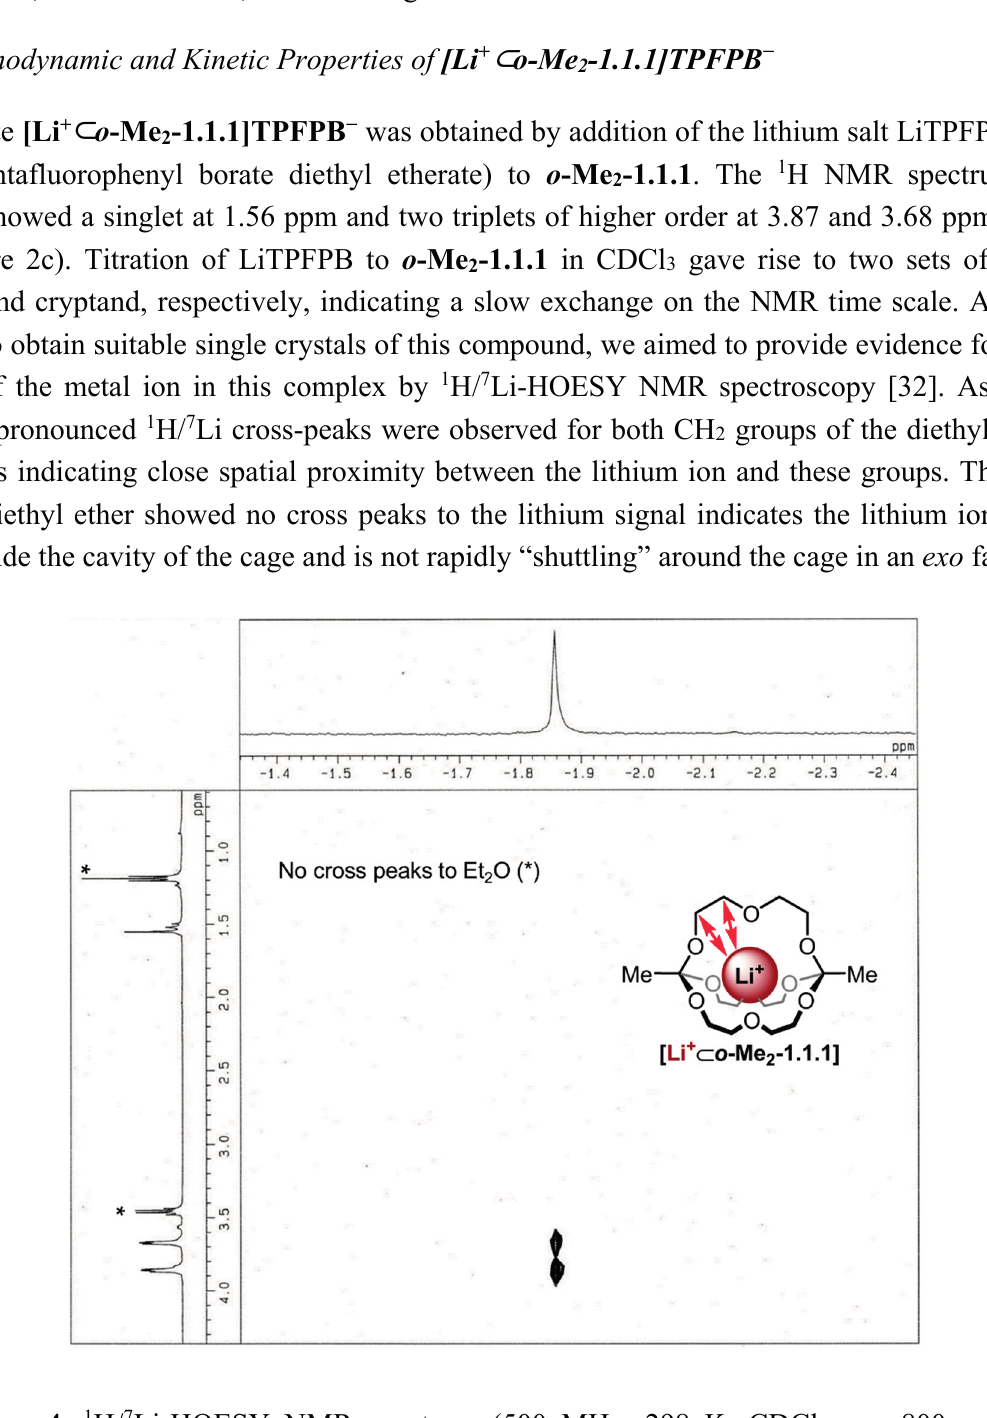
Figure 4. 1 H/ 7 Li-HOESY NMR spectrum (500 MHz, 298 K, CDCl 3 , τ m : 800 ms) of -1.1.1]TPFPB − , * : Peaks correspond to Et 2 [Li + ⊂ o -Me 2